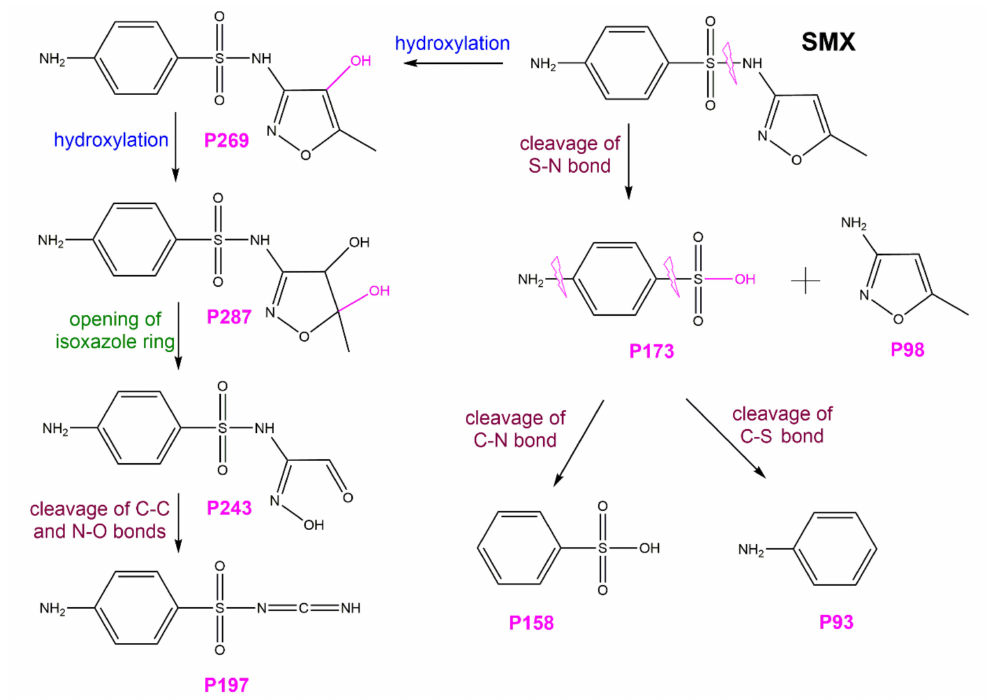
Scheme 2. Proposed degradation pathways of SMX in photocatalytic oxidation over TiO 2